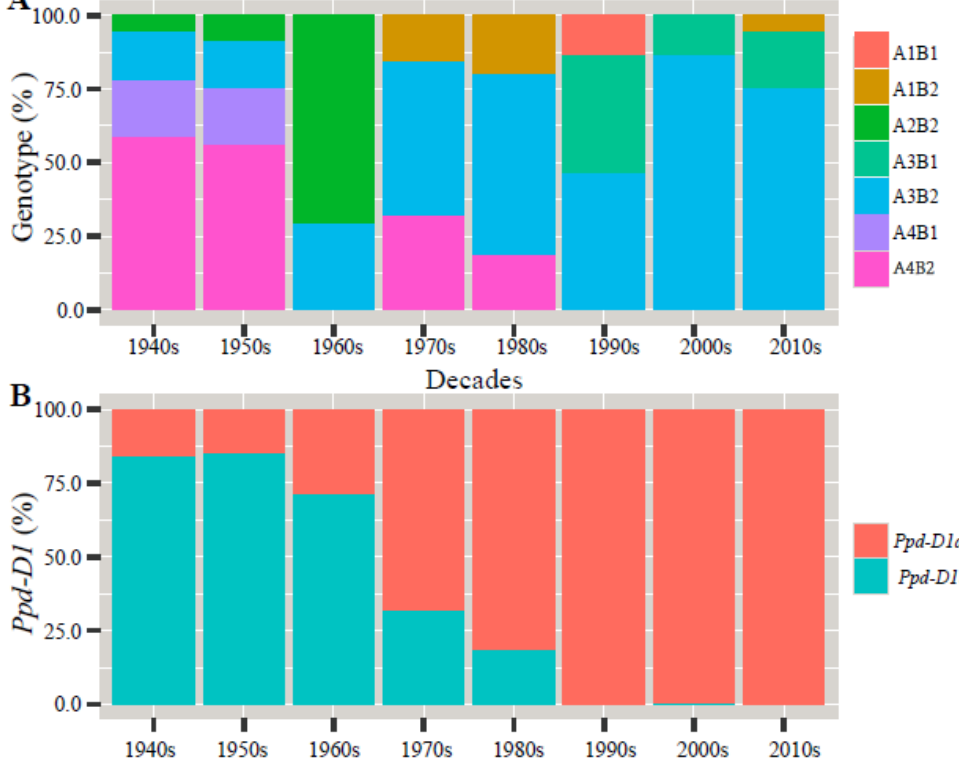
Figure 2. Percentage column plots of genotype and photoperiod genes in different eras for 100 wheat varieties evaluated in three growing seasons: ( A ) the percentage of the combined genotypes to their eras of release; ( B ) the percentage of the Ppd-D1 allele to their eras of release.